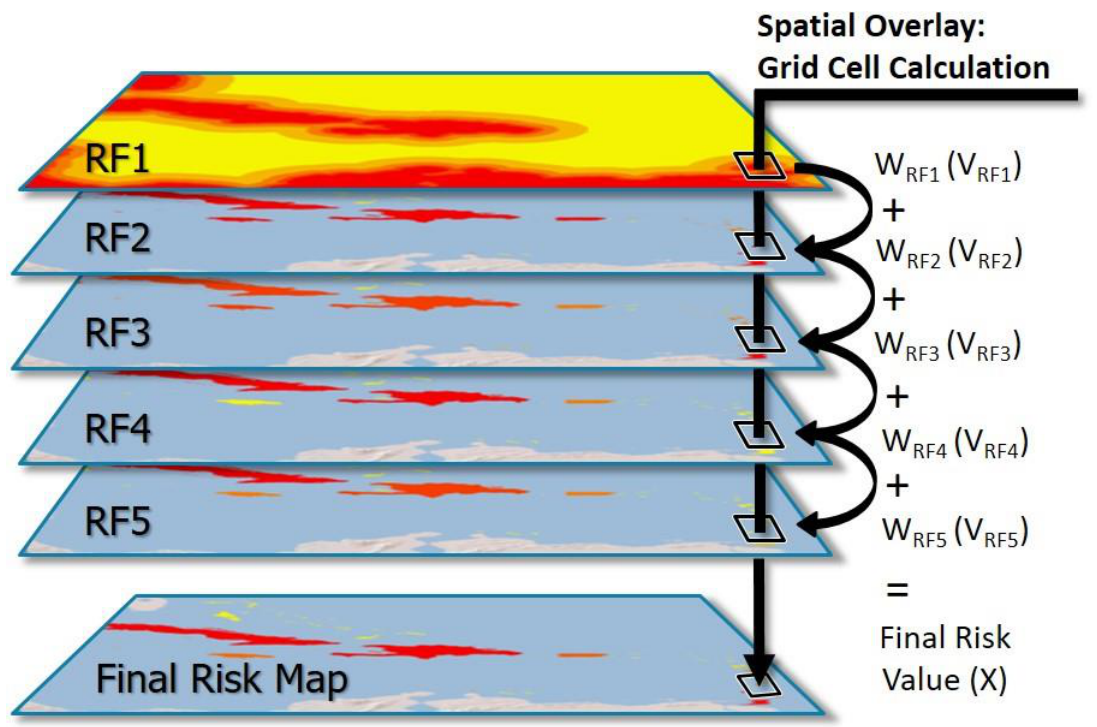
Figure 2. Risk map spatial overlay and grid cell calculation. Visualization of the spatial overlay of each risk factor (RF) raster file to create the final risk map. Within each grid cell of a RF layer, the grid cell value (V) was multiplied by the weight of its RF layer (W), and these values were then summed between all correlating grid cells to get a final risk value (X).